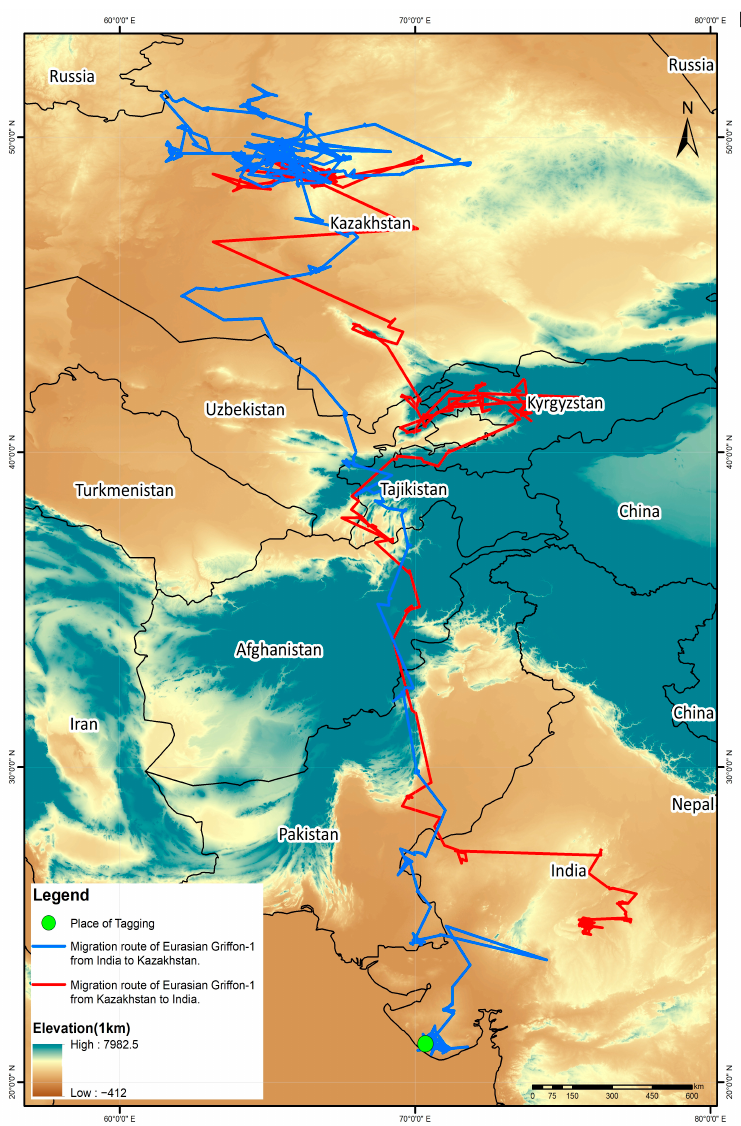
Figure 4. Migration route of Eurasian griffon-1 from Saurashtra Landscape to Kazakhstan (blue line) during pre-breeding season and from Kazakhstan to India (red line) during post-breeding season. Green dot represents the place of tagging. This map was generated using ArcGIS 10.8.1. Redlands, ESRI, California, USA. Country borders represented here are according to Google Earth imagery (Google India).